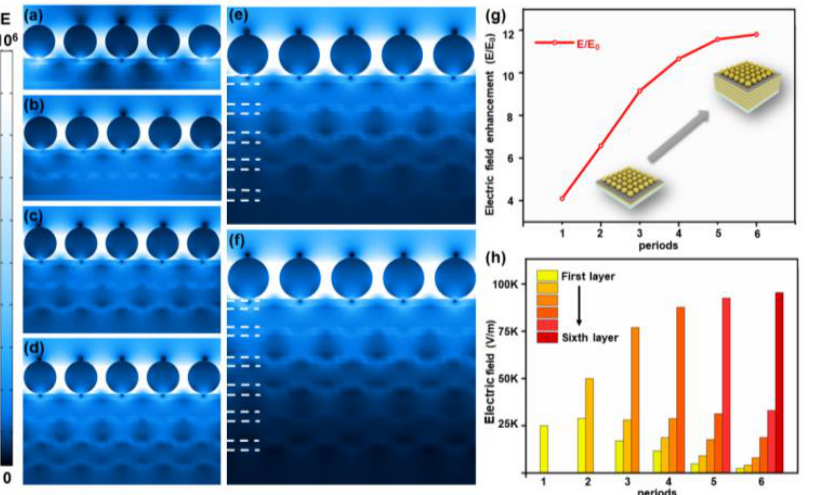
Figure 4. ( a – f ) The simulations of the electric field distribution from one to six Au/Al 2 O 3 bilayers. ( g ) The electric field enhancement ( E / E 0 ) in different periods. ( h ) The electric field intensity of each Au/Al 2 O 3 bilayer in different periods.